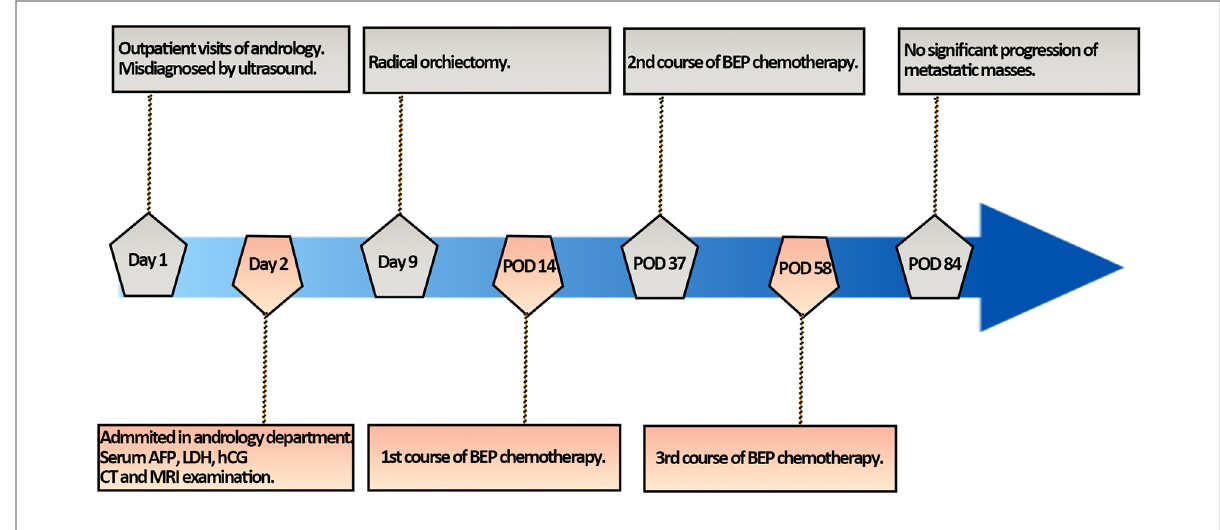
FIGURE 4 The fl owchart of timeline for diagnosis and treatment process. POD, postoperative